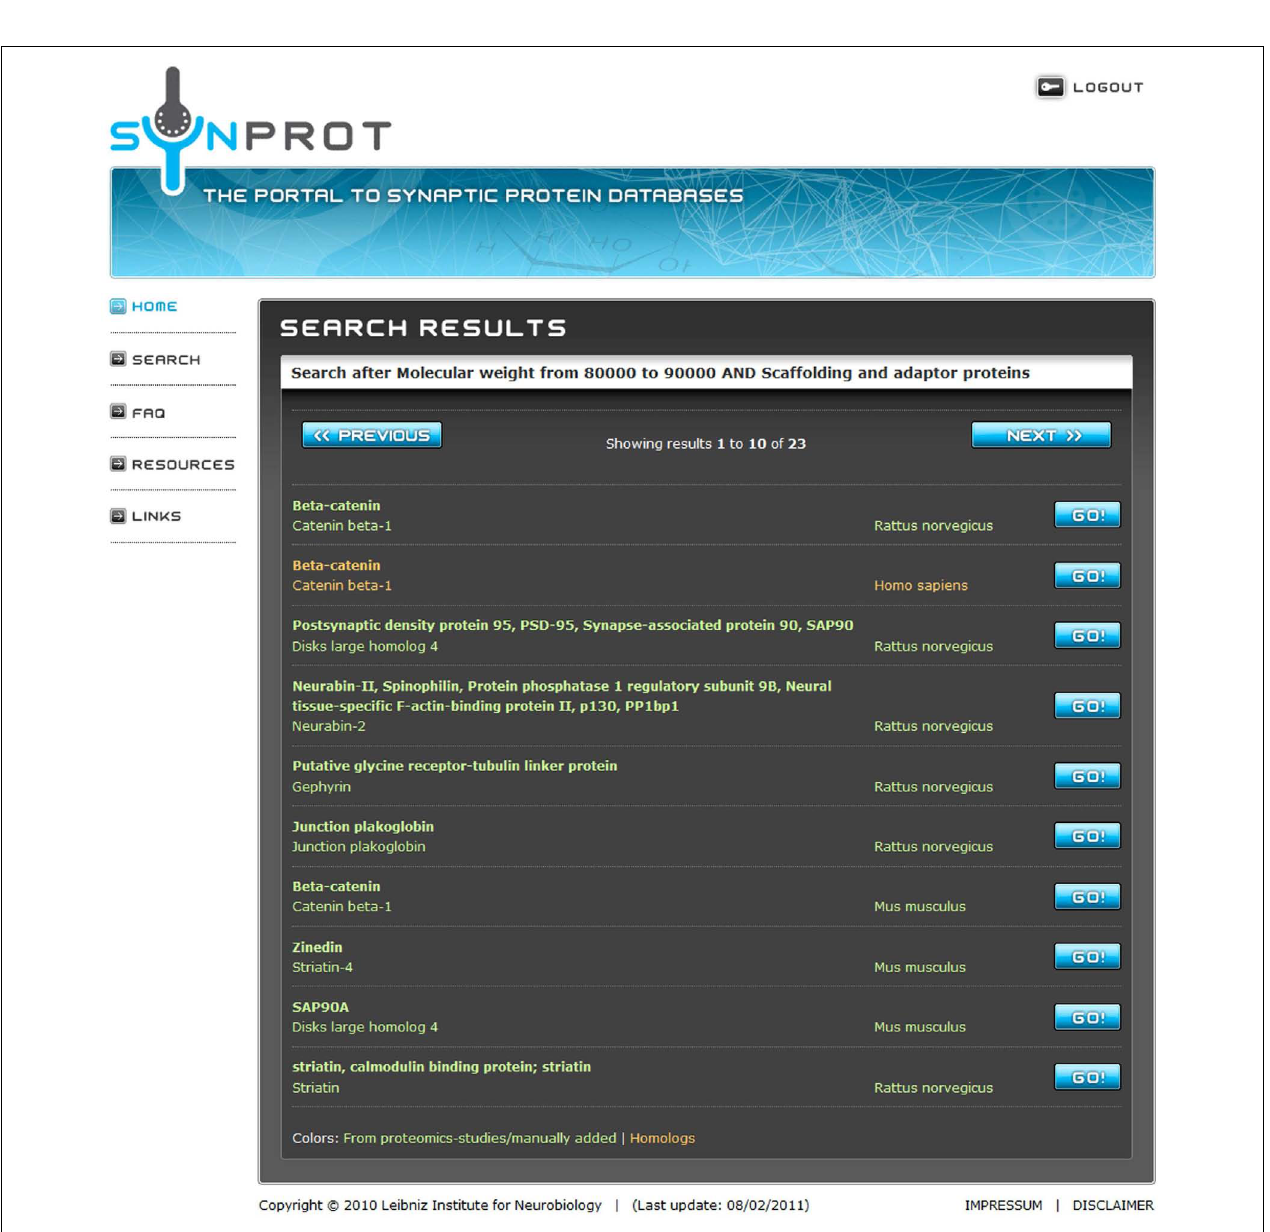
are derived from UniProt due to homology. By clicking on the “Go!” Button, the user can choose the dataset of choice.The third and the ninth position show entries of the well-known postsynaptic protein PSD-95/SAP90 from different